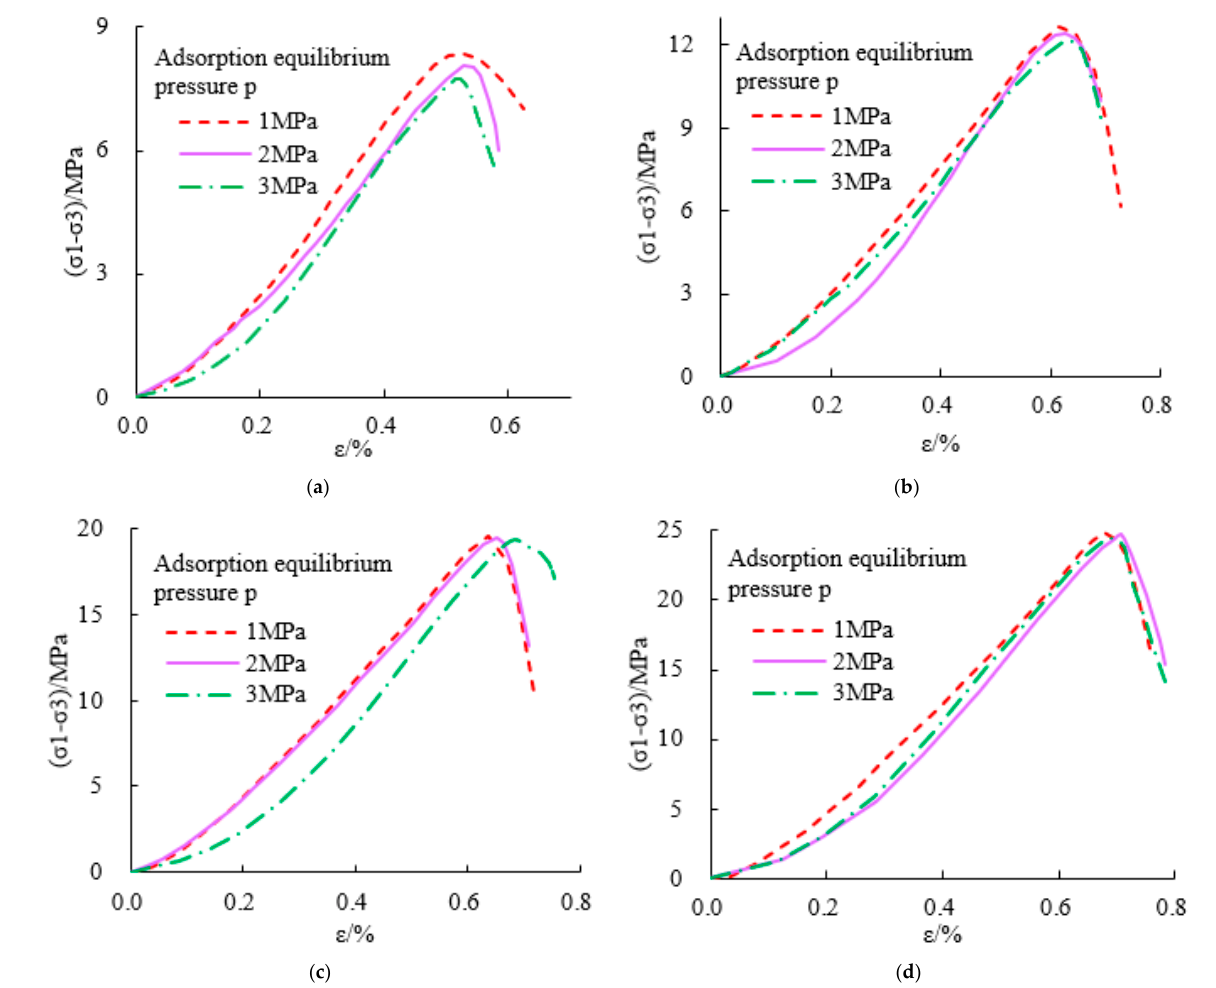
Figure 3. Gas coal triaxial compression stress-strain curve. ( a ) Stress-strain curve of Gas coal when confining pressure is 0 MPa. ( b ) Stress-strain curve of Gas coal when confining pressure is 3 MPa. ( c ) Stress-strain curve of Gas coal when confining pressure is 6 MPa. ( d ) Stress-strain curve of Gas coal when confining pressure is 9 MPa.